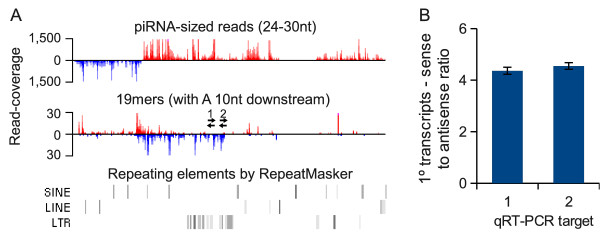
A piRNA cluster giving rise to both piRNAs and pr19RNAs A) A bidirectional piRNA cluster is presented (NCBI37/mm9 coordinates: chr6:127,734,347-127,787,210). The coverage of piRNAs-sized reads (24-30nt) and 19mers (with A 10 nt downstream) is visualised by wiggle-plots with reads mapped from left to right above the x-axis and reads mapped from right to left below. Only uniquely mapping reads are plotted. The position of repetitive elements, adapted from the UCSC Genome Browser [15], is indicated below the plots. The approximate position of two PCR targets used for strand-specific real-time quantitative reverse transcription PCR (qRT-PCR) is also indicated. B) The abundance of the piRNA precursor transcript relative to that of an overlapping antisense precursor transcript is presented. The fold-difference was estimated by strand-specific qRT-PCR targeting two separate loci, as indicated.